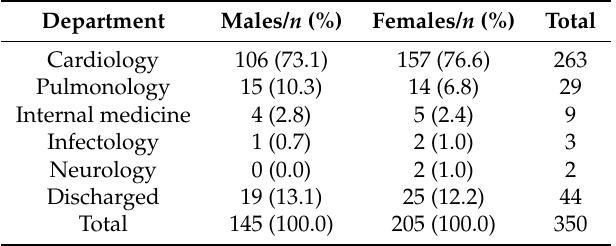
Hospital admission rates of patients who tested positive on hs-cTn I and gender-related